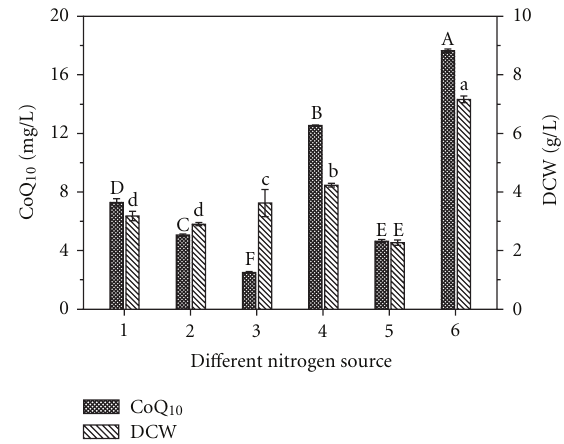
Figure 4: E ff ect of various nitrogen sources on the cell growth and CoQ10 production. Cells were cultivated in the test tube at 28 ◦ C for 72h. The nitrogen sources included yeast extract (1), peptone (2), tryptone (3), soytone (4), ammonium sulfate (5), and CSP (6). Data are shown as mean ± SD ( n = 3). Means with the same letter are not significantly di ff erent ( P < 0 .